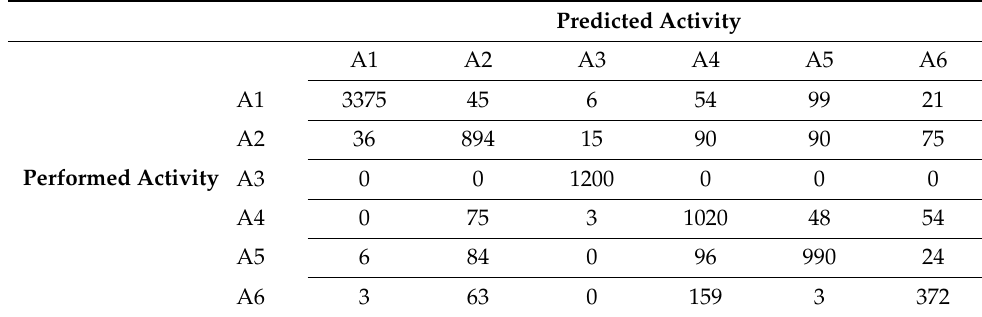
Table 14. The confusion matrix obtained for the fifth evaluation